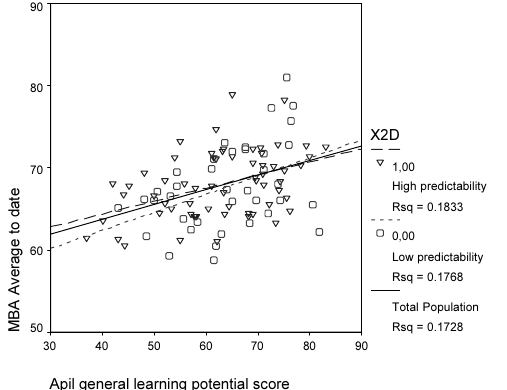
Figure 3: MBA average performance as a function of learning potential depicted for high (X 2 D=1) and low predictability (X 2 D=0) groups separately (predictability index based on real residuals).